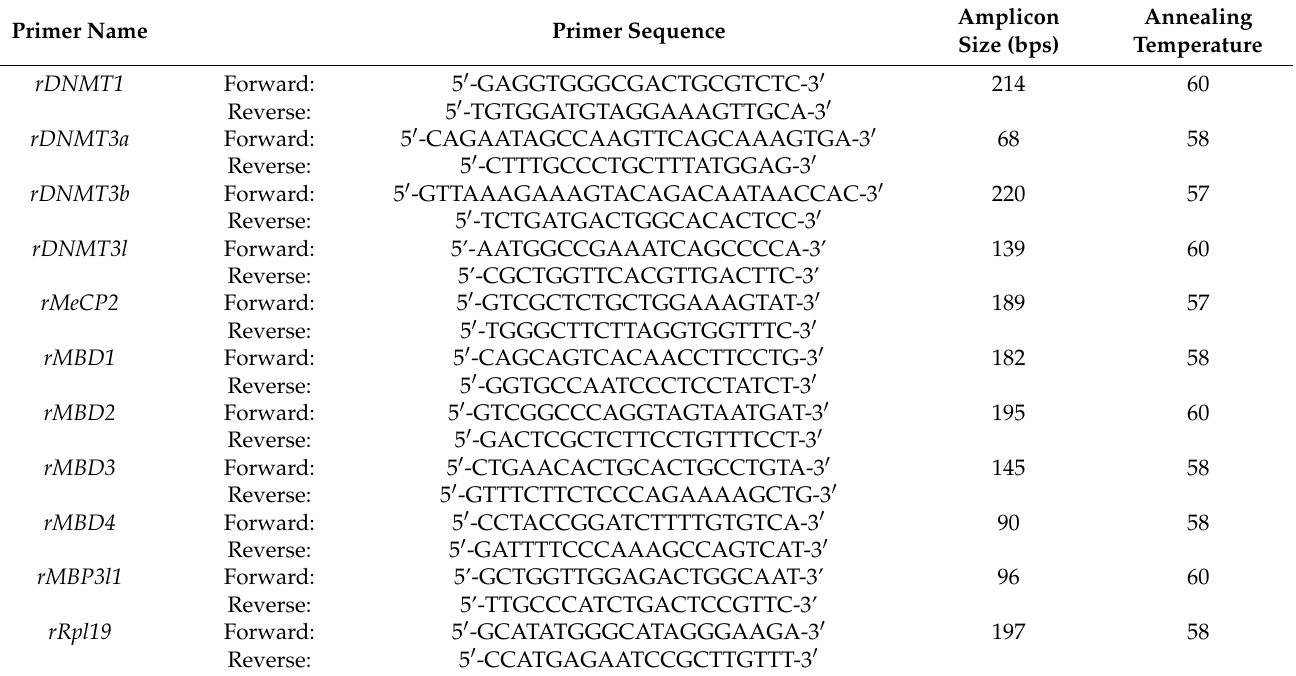
Table 2. Primers used for real-time PCR.